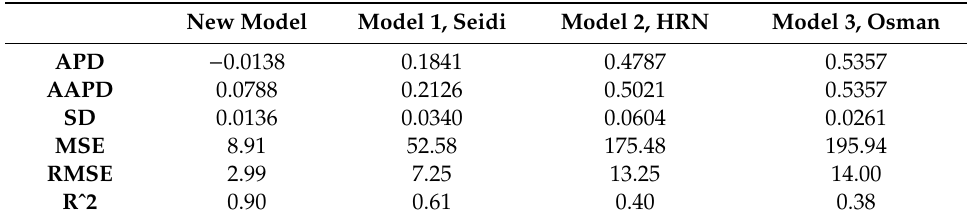
Table 7. A comparison of six di ff erent measures of accuracy corresponding to di ff erent models using the production data set of the 40 / 64 inch choke